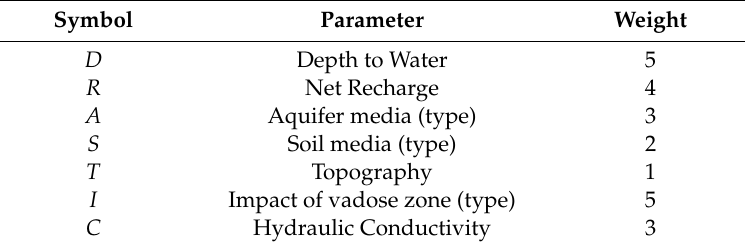
Table 1. Weight values for the DRASTIC parameters [11].